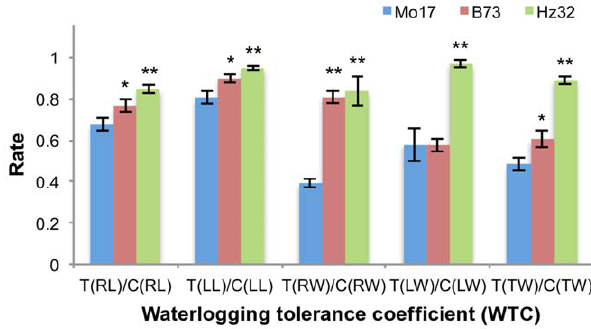
Figure 2. Short-term waterlogging phenotype-screening re- sults of all three inbred lines. T: Waterlogging treatment. C: Control. RL: Root Length. LL: Leaf Length. RW: Root dry Weight. LW: Leaf dry Weight. TW: Total dry Weight. Error bars show the standard deviation. Student t-test was performed on the tolerant line (Hz32) and mid- tolerant line (B73), comparing with sensitive line (Mo17). ** denotes the p-value below 0.01 and * denotes the p-value below 0.05.